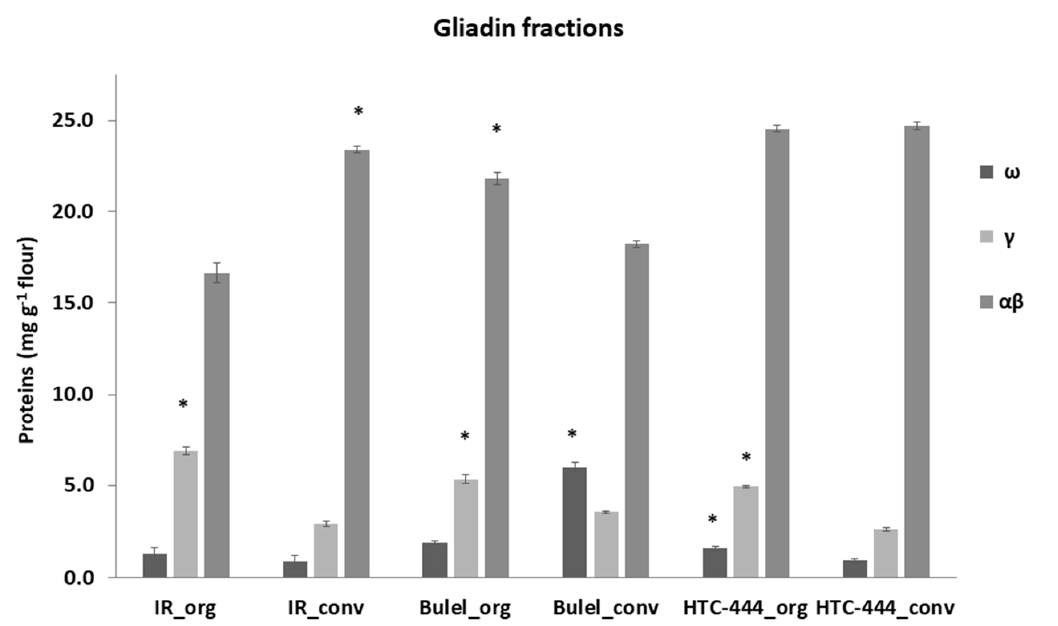
Figure 3. Gliadin subunits ( ω , γ , α / β ) separated by SDS-PAGE in durum wheat cv. Iride, and Tritordeum cv. Bulel and HTC-444 under organic and conventional systems. Data are reported as averages of 3 replicates ± standard deviation. Significant differences between organic (org) and conventional (conv) systems for the same cultivar are indicated with asterisks (* p ≤ 0.05).